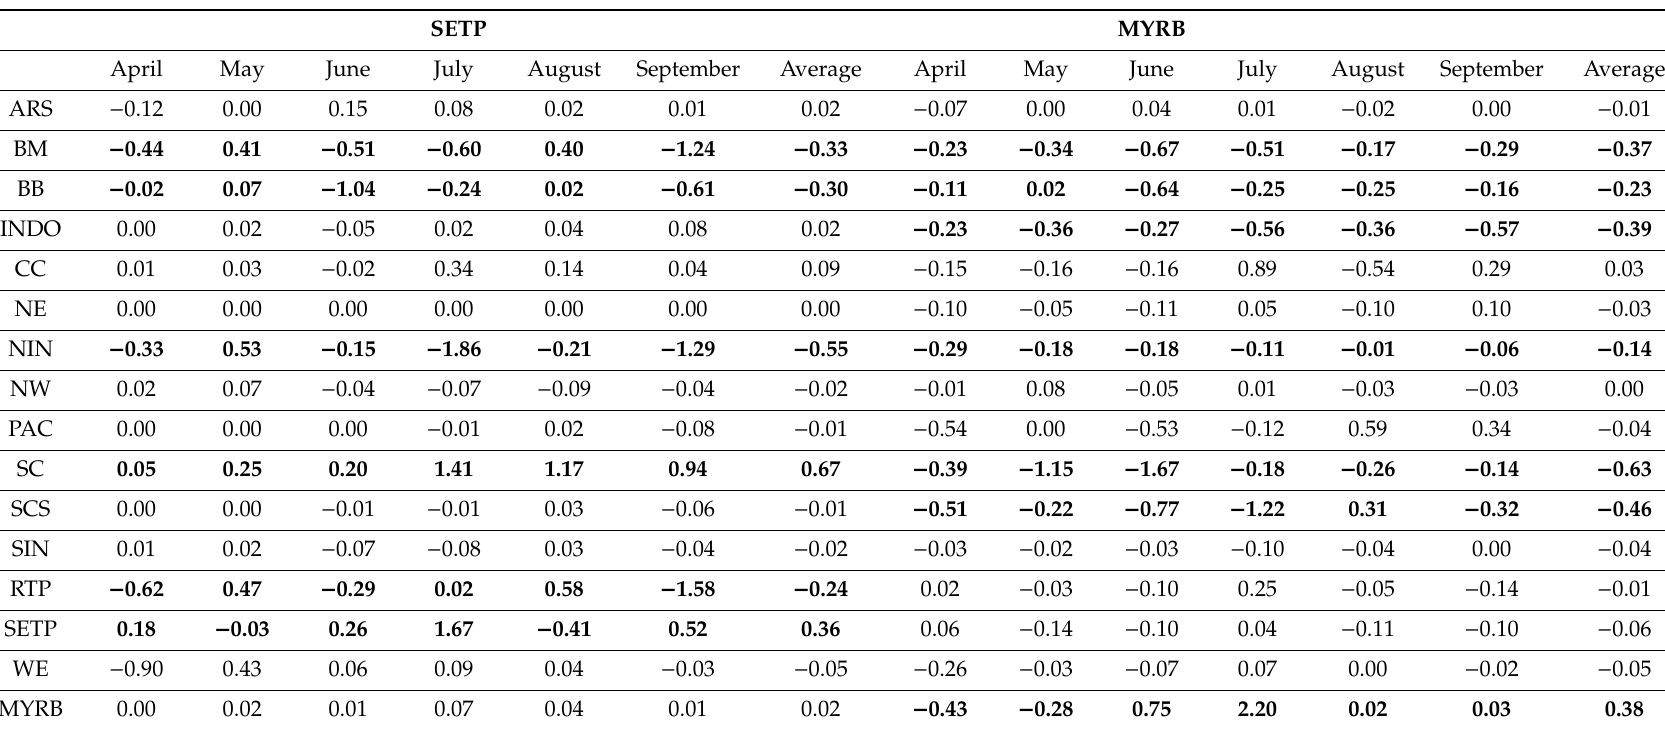
Table 3. Linear trends of the monthly and wet season (April–September) average of evaporative sources (unit: mm d − 1 a − 1 ) in the 16 sub-regions, contributing to precipitation in the SETP and MYRB over 1982–2011. Absolute changes larger than the threshold of 0.16 mm d − 1 a − 1 for SETP and 0.08 mm d − 1 a − 1 for MYRB (this criterion is based on the three-sigma rule) are marked in